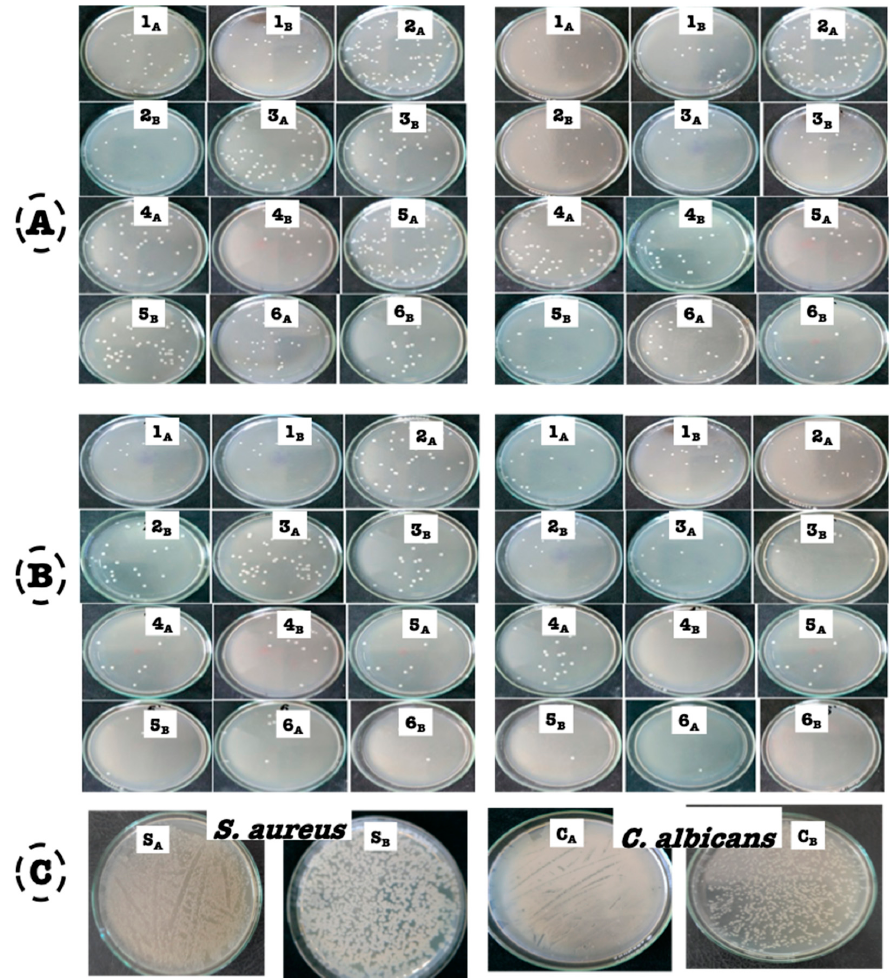
Figure 6. Effect of killing time of anise oil-based nanoemulsion against C. albicans and S. aureus: ( A ) after 2 h ( B ) after 24 h, A -first dilution, B -second dilution, ( C ) control-tested microbes; A, B , first and second dilutions for S. aureus and C. albicans ,